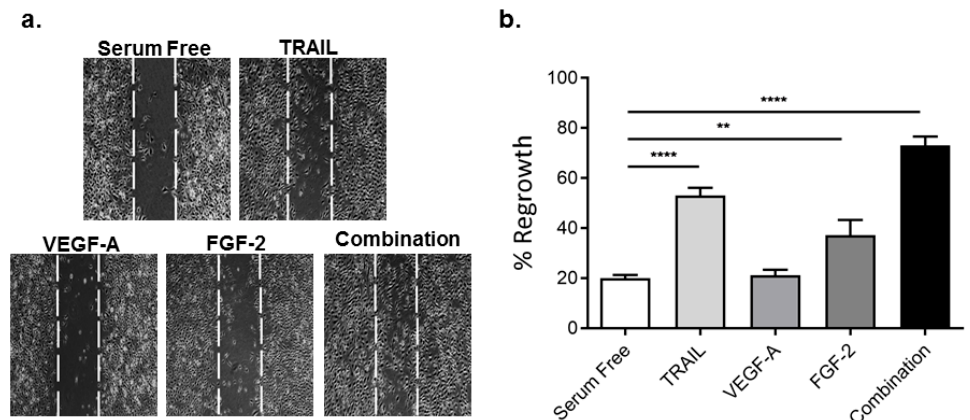
Figure 2. TRAIL and FGF-2 promote HMEC-1 migration. An in vitro scratch injury was performed in serum-arrested HMEC-1 cells followed by treatment with TRAIL (10 ng/mL), VEGF-A (10 ng/mL), FGF-2 (10 ng/mL) or the combination of all three (each at 10 ng/mL) as describe in the Methods. Images were taken 24 h later. ( a ) Representative images 10× magnification; the denuded zone is depicted by the space between the dashed lines; ( b ) quantification of cell migration ( n = 3/condition) as described in the methods . Results are expressed as the mean ± SEM; ANOVA; ** p < 0.01, **** p < 0.0001.